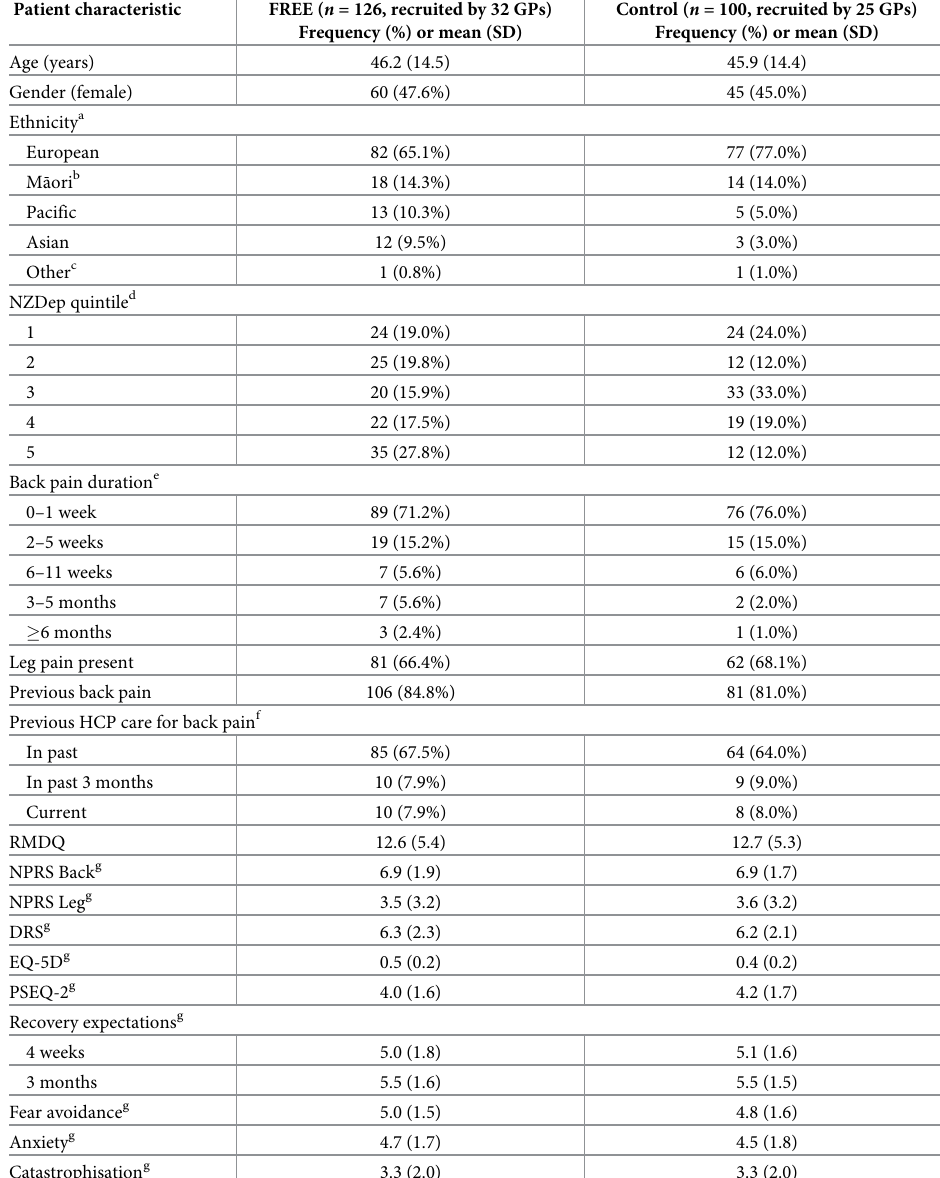
Table 2. Baseline characteristics of patient participants. Patient